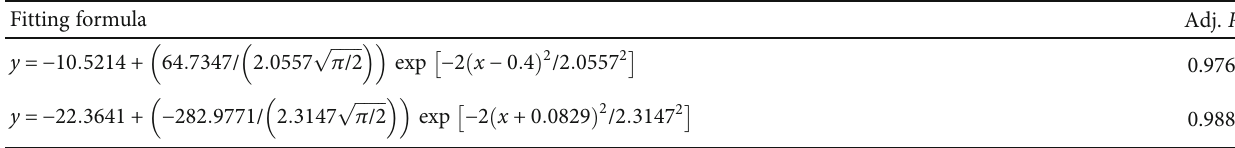
Figure 11: Stress on rebar on day 45. Table 1: Fitting